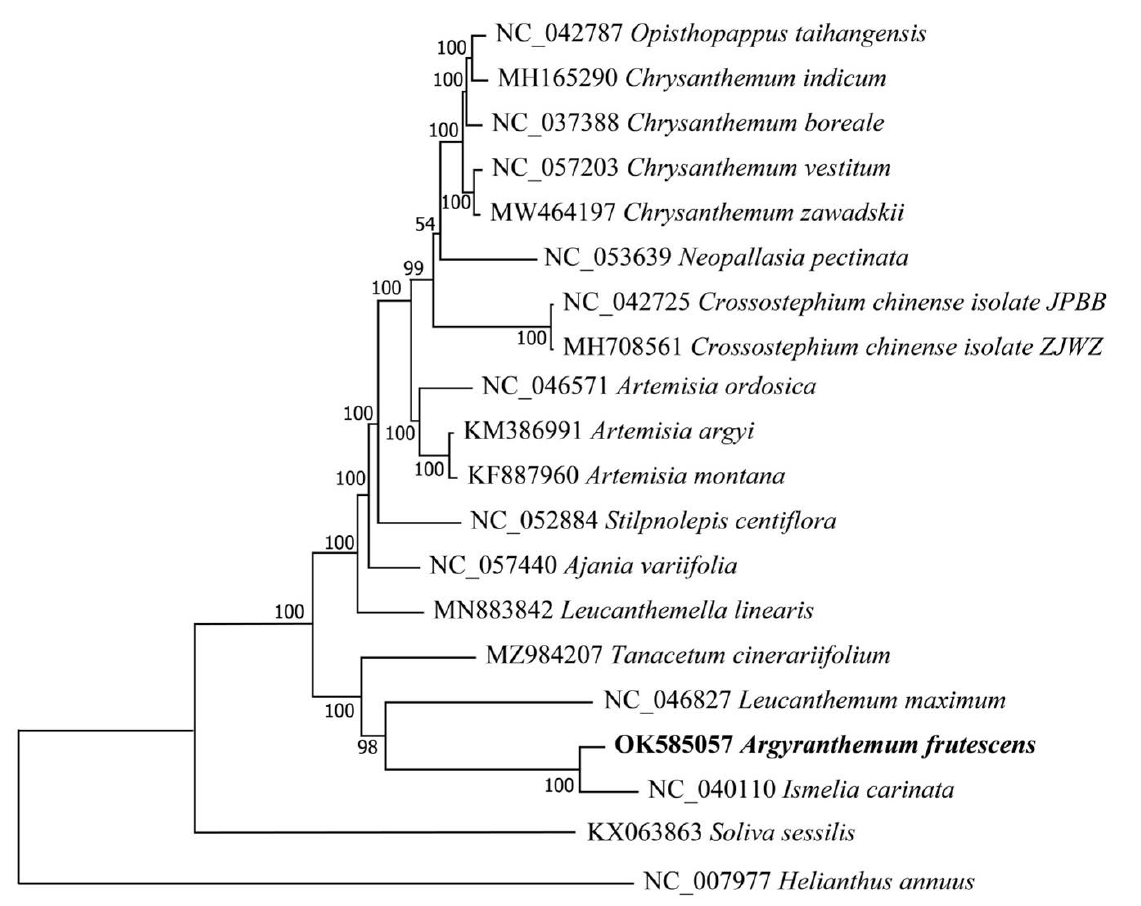
Figure 5. Maximum likelihood (ML) tree of 19 species in different genera of Anthemideae based on the whole chloroplast genomes.